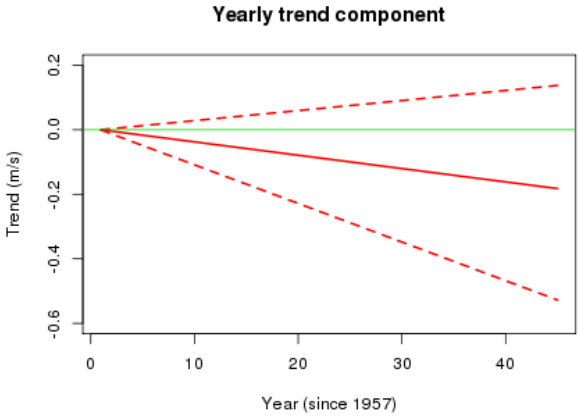
Fig. 7. The posterior mean long-term trend component with 90% credible interval of γt ; green line corresponds to no trend.